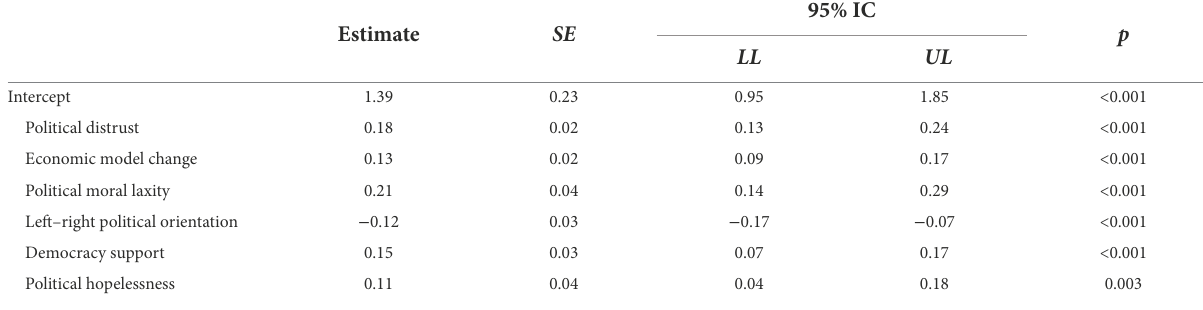
TABLE 3 Multiple linear regression of political cynicism, attitudes toward democracy and socio-political characteristics (IV) on the populist demand dimension (DV).